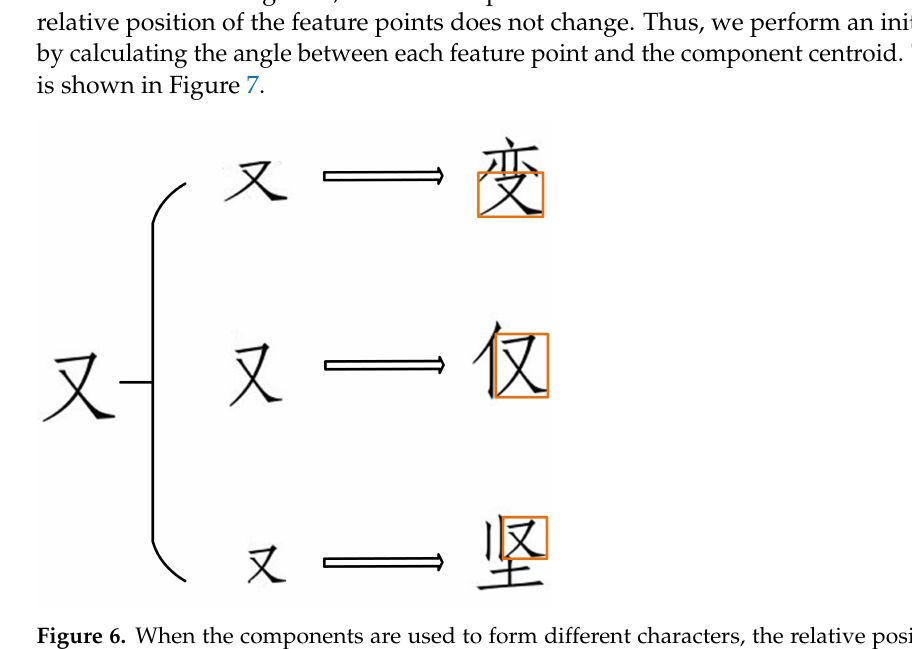
Figure 6. When the components are used to form different characters, the relative position of the feature points does not change.